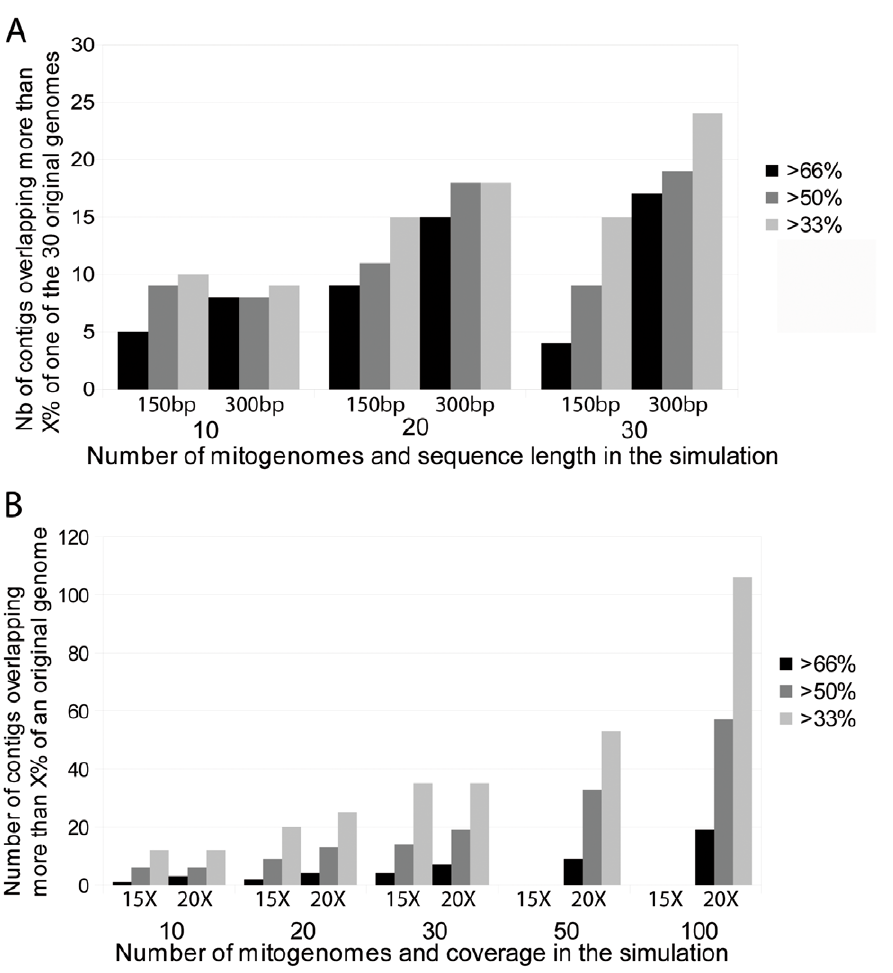
Figure 5. Number of contigs overlapping . X% against the number of mitogenomes. a. for two different sequence length (Ion Torrent simulations) e.g. in the simulation with a mean read length of 300 bp, there are 19 contigs overlapping more than 50% of 19 of the 30 mitogenomes. Two contigs overlapping a mitogenome by about 33% can belong to the same mitogenome, while there is only one contig that can cover 50% or 66% of a mitogenome. Overlap % calculated against an average mitogenome size (16 400 bp). b. for two different coverages (454 simulations) e.g. For 15 6 coverage, there are 9 contigs overlapping more than 50% of 9 of the 20 mitogenomes). Overlap % calculated against an average mitogenome size (16400 bp). The mean coverage of 15 6 correspond to coverages varying between 10 and 21 for the simulated individual mitogenome, and those of 20 6 correspond to coverages between 19 and 21. Note: in the simulation for 50 and 100 mitogenomes, the 15 6 coverage is not sufficient for MIRA to achieve the